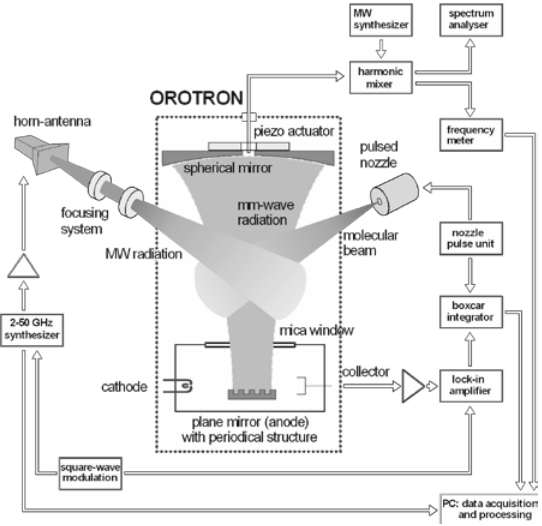
Fig. 1. Schematic diagram of the OROTRON jet spectrome- ter (100-150 GHz) with MW–MMW double resonance ar-